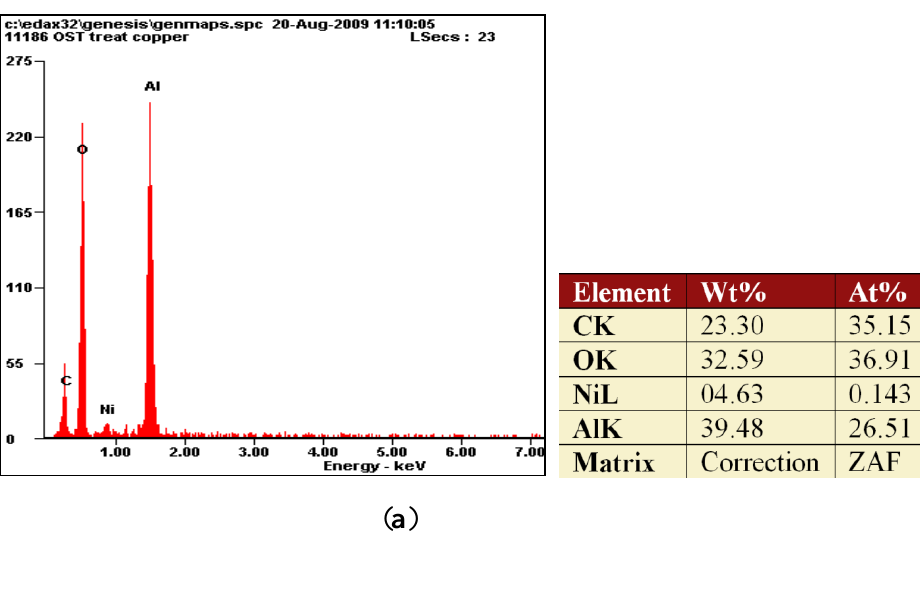
Figure 2. Energy Dispersive X-Ray Microanalysis (EDAX) plots of a section of ( a ) Ni-P plated for 2 min; ( b ) Ni-P plated for 10 min; ( c ) Ni-Mo-P plated for 2 min; ( d ) Ni-Mo-P plated for 10